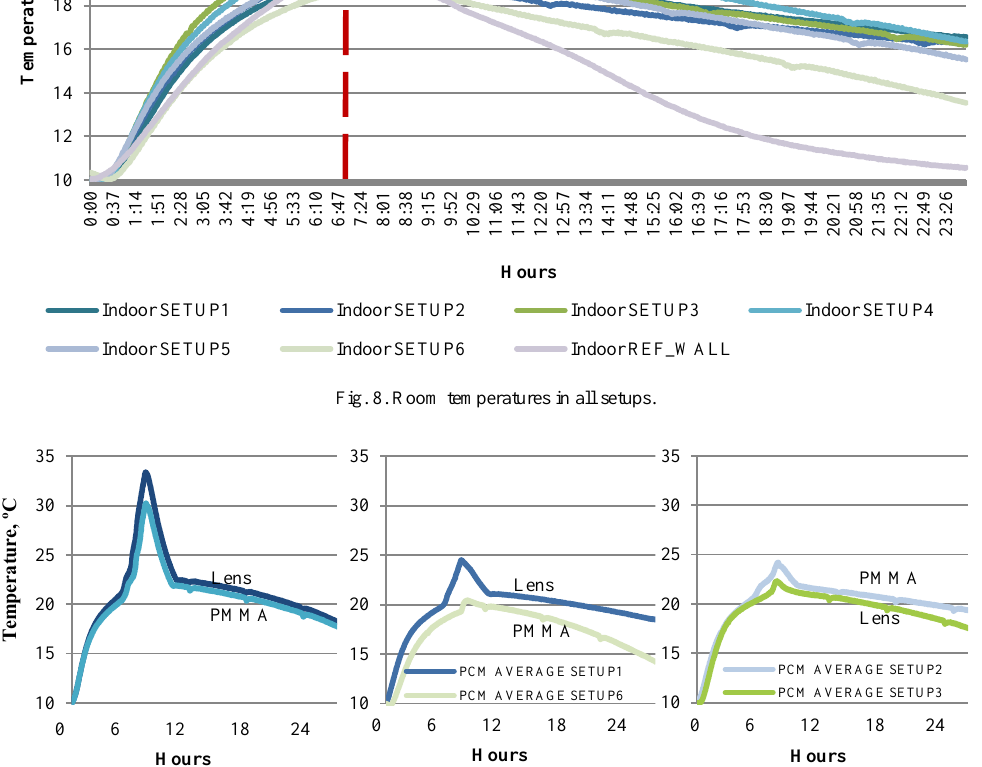
Fig. 9. Fresnel lens vs PMMA glass – average temperature in PCM: (a) air space; (b) cone + aerogel, (c)